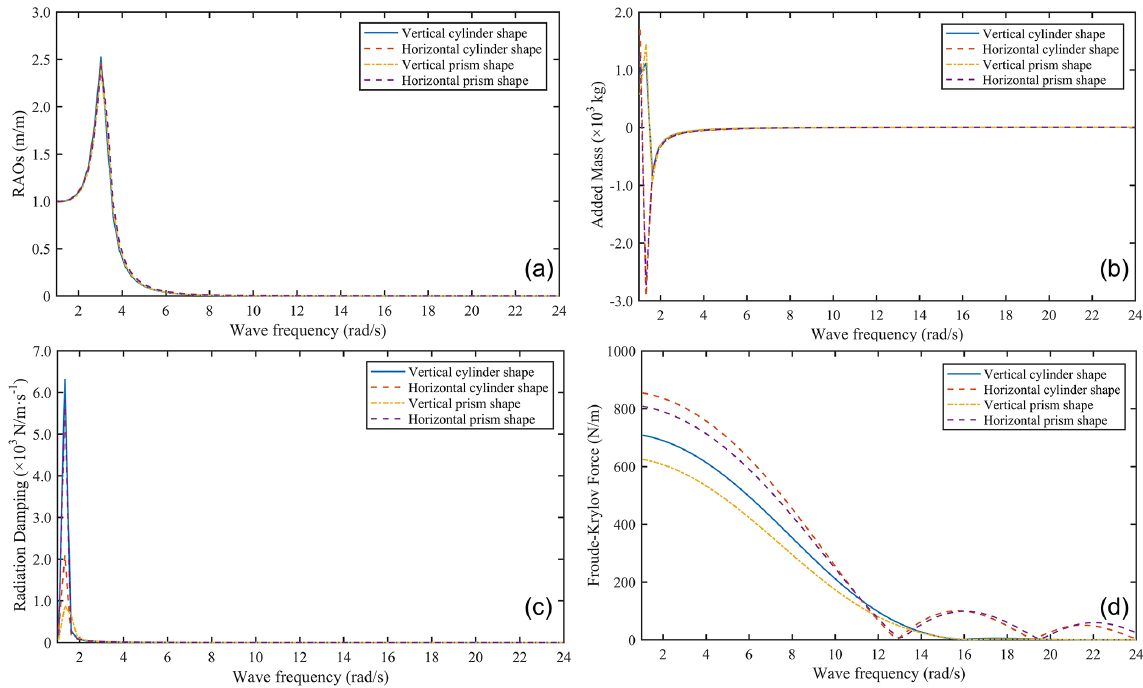
Figure 4. Energy efficiency comparison of cylinder and prism floating bodies. (a) RAOs. (b) Radiation damping. (c) Added mass. (d) Froude–Krylov force.